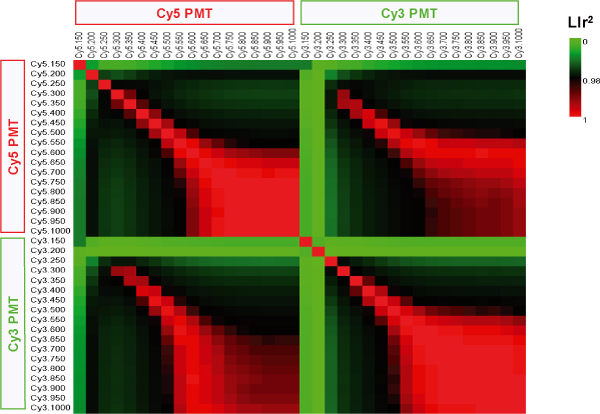
Reproducibility of log intensities. This is a color-image presentation of a 36 by 36 square matrix. Each square block represents the squared Pearson correlation coefficient of log intensities (LIr2) for two series of intensity data scanned at two PMT settings. The diagonal represents self-self correlation. Red color means higher correlation, whereas green indicates lower correlation. Only 14 concentration series are used in the calculation of LIr2.